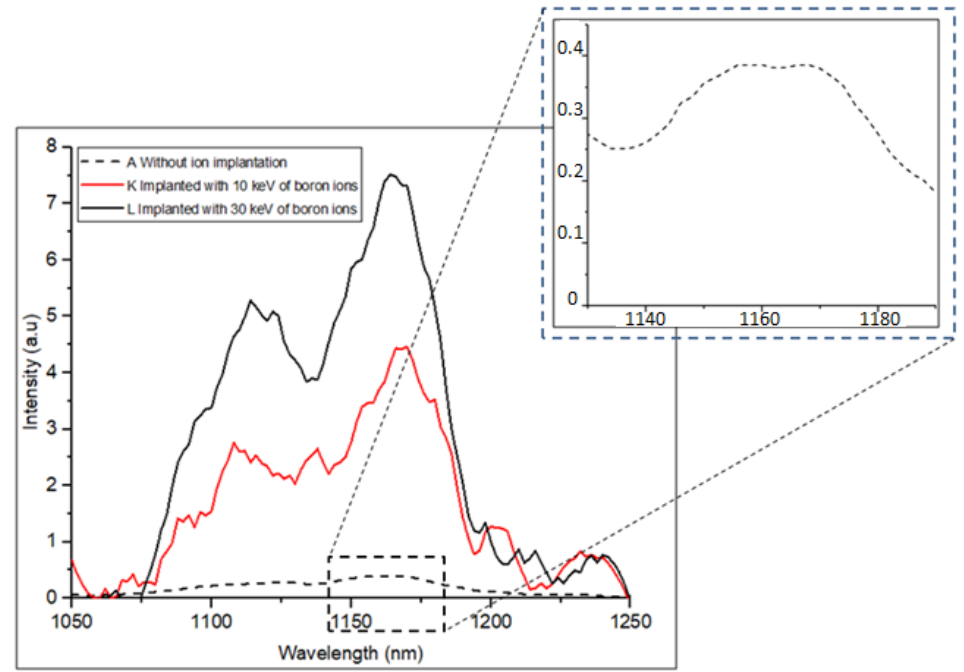
Figure 6. PL spectrum of samples A, K and L at 80 K. Sample A is the reference sample without any implantation. Samples K and L are implanted with 10 and 30 keV of boron ions. The inset shows the peak at 1170 nm for sample A. Laser power is 200 mW. FWHM for sample L is 46 nm (43 meV).